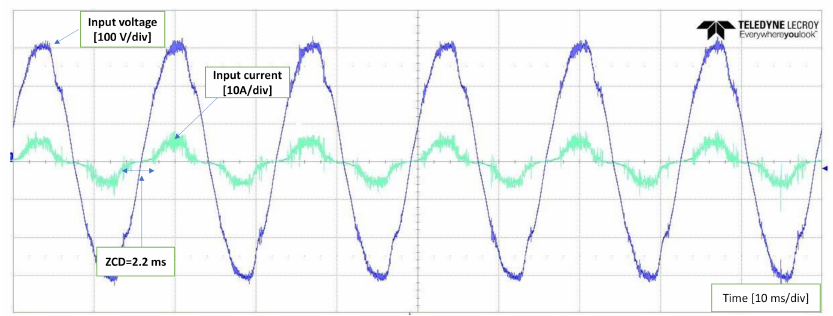
Figure 35. Experimental waveforms of the supply voltage-current with the conventional PI